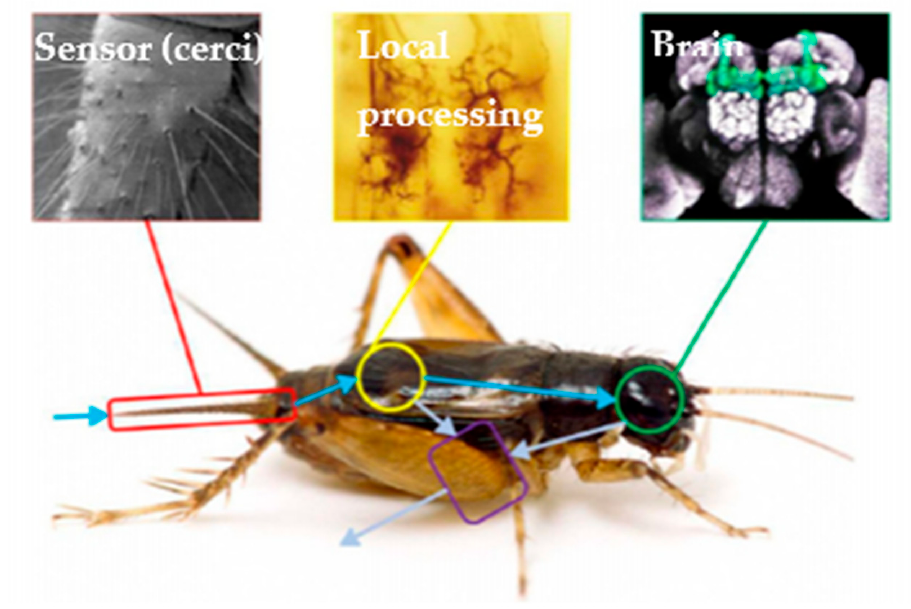
Figure 1. New findings in insect neural systems reveal that they have local integrated sensing and computing neurons to reduce computing demands at the central processing unit (the brain) [7].